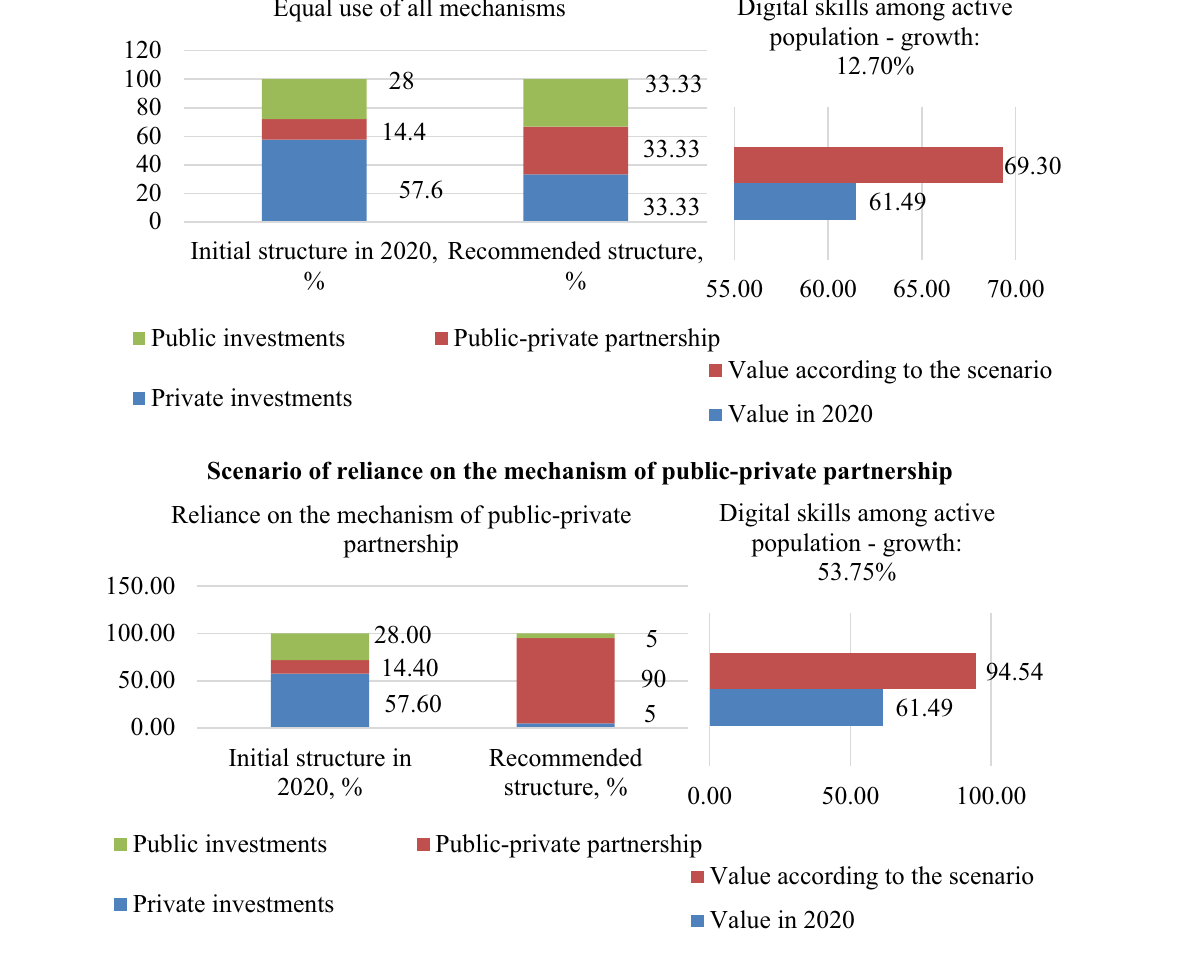
FIGURE 2 Education management in the social and investment model of economic growth according to the scenario of equal use of mechanisms and according to the scenario of reliance on the mechanism of public-private partnership Source: calculated and built by the